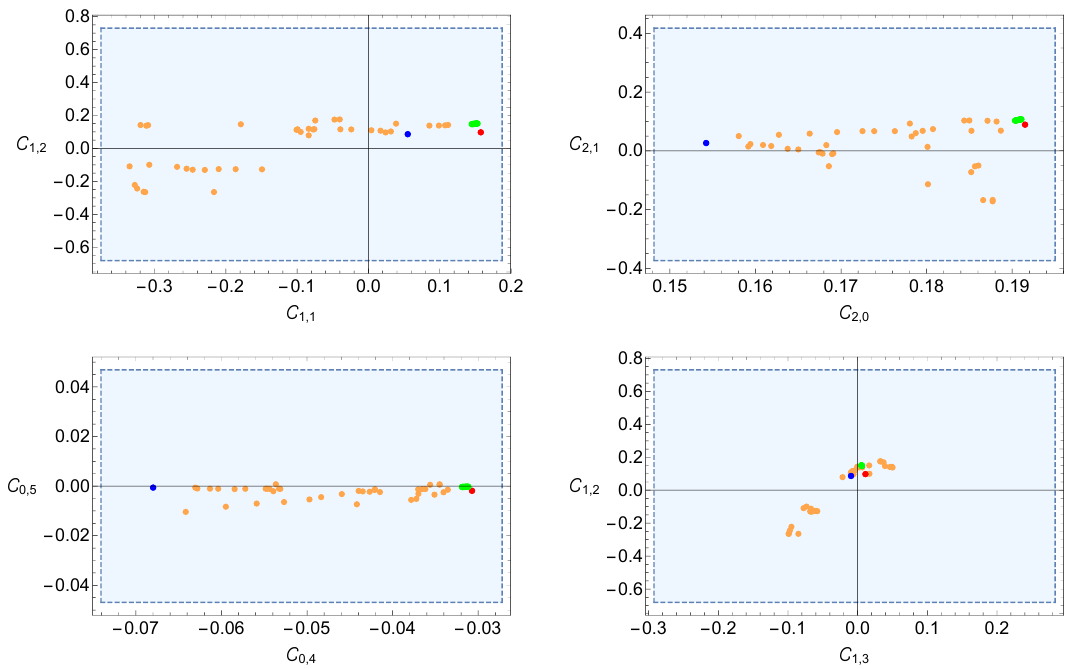
Figure 2 . The light blue region is the theory space allowed by the constraints in the table 3. Some of the known theories are indicated. Green region is the O (3) Lovelace-Shapiro model (A.1) (1 − β ) and β varies from 0 . 465 < β 0 . 489 (see [36]). The red dot is the O (3) with β 0 = 1 0 0 0 < m 2 ρ Lovelace-Shapiro model (A.1) with β = β 0 = 1 / 2 . The blue dot is the 2-loop chiral perturbation 0 theory with parameters are taken from experimental values. The orange regions are obtained from the S-matrix bootstrap amplitude for the upper river boundaries [36,